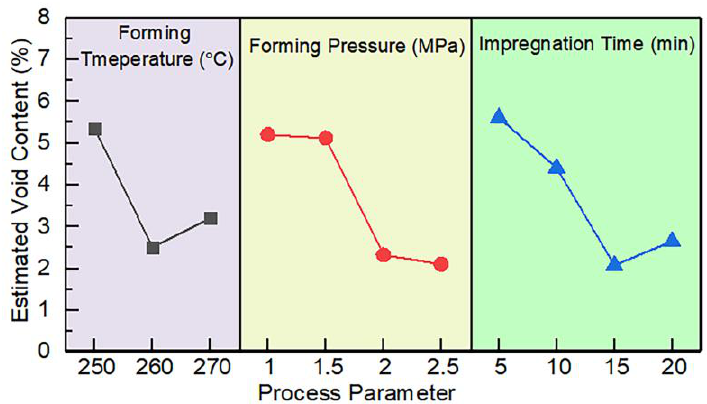
Figure 6. The effect of process parameters on the void content.